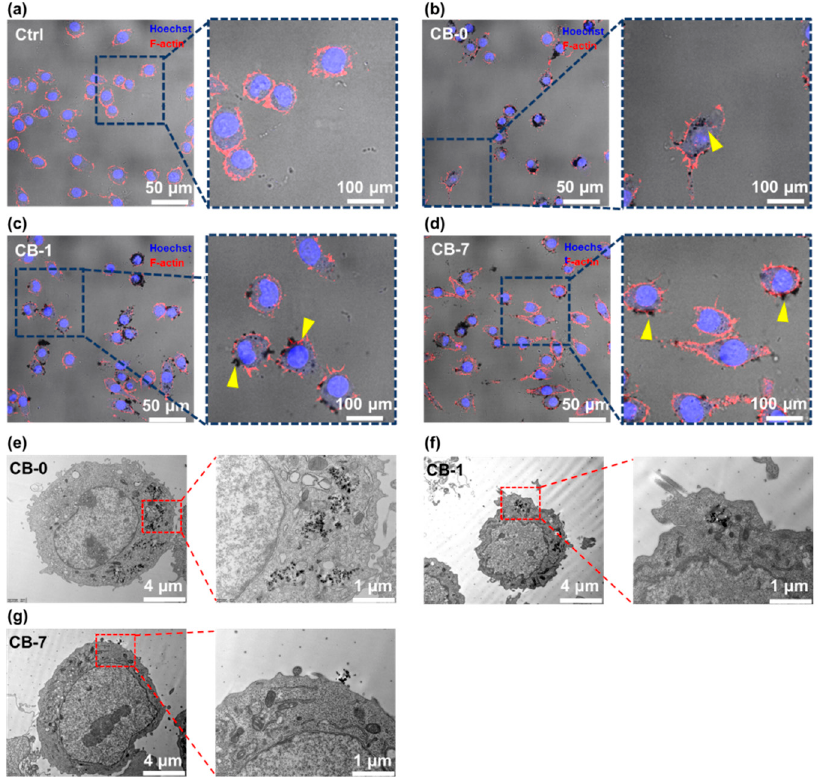
Figure 4. Interactions between CB particles and macrophages. ( a – d ) Confocal laser scanning microscopy images of J774A.1 macrophages after exposure to CB particles (10 µg/mL) at 24 h. The red and blue fluorescence signals represent the cytoskeleton (F-actin) and nucleus, respectively. The particle aggregates are denoted by yellow arrowheads. ( e – g ) TEM images displaying the intracellular localization of CB particles in J774A.1 cells upon treatment at 10 µg/mL for 12 h. Abbreviations: CB, carbon black.